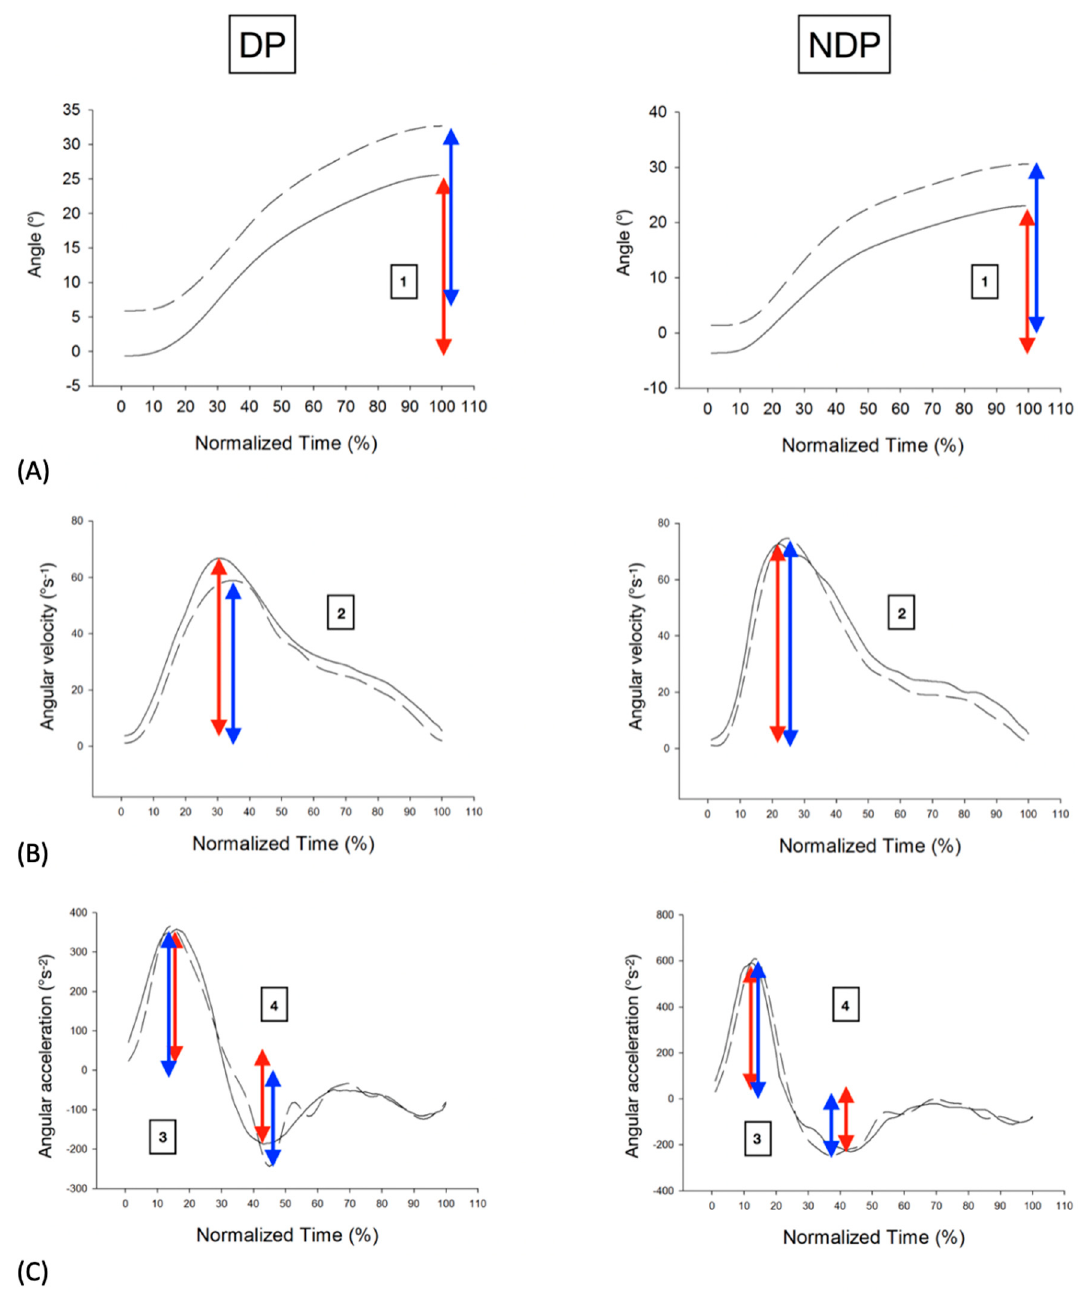
Figure 6. Typical plots of variables analyzed during one right rotation in a DP (34 years, Male, NDI = 22, NRPS = 5) and an NDP (25 years, Male, NDI = 0, NPRS = 0): ( A ) Angle; ( B ) Angular velocity; ( C ) Angular acceleration. Elite curves (dotted lines) can be compared to DYSKIMOT ones (solid lines). Computed parameters are illustrated by blue (Elite) or red (DYSKIMOT) arrows. (1) angle; (2) peak angular velocity; (3) peak angular acceleration; (4) peak angular deceleration.